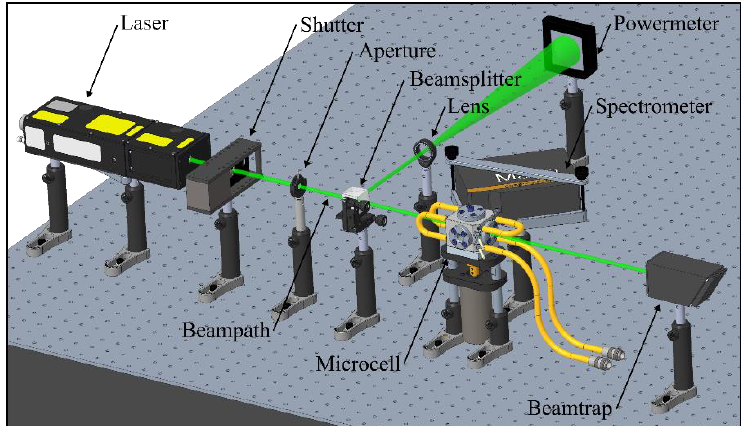
Figure 1. Optical setup for the fluorescence measurements.